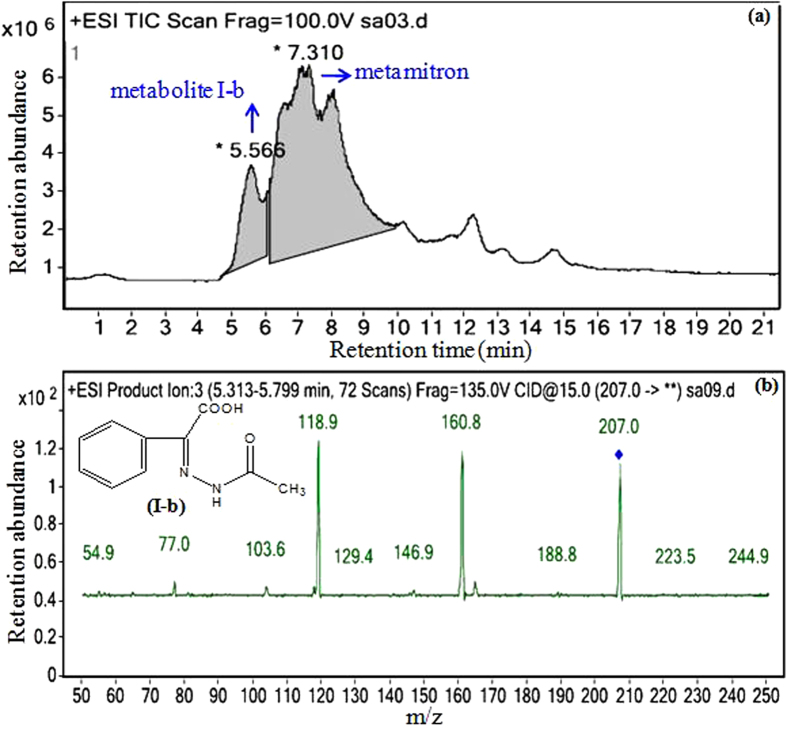
Total ion chromatogram of metamitron degradation by the isolate MET (a), mass spectrum and the proposed structure of metamitron metabolite I-b (b) in mineral salts medium using extraction method II.